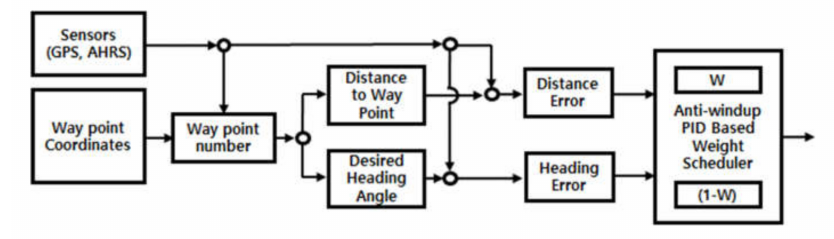
Figure 18. Diagram for tracking control.